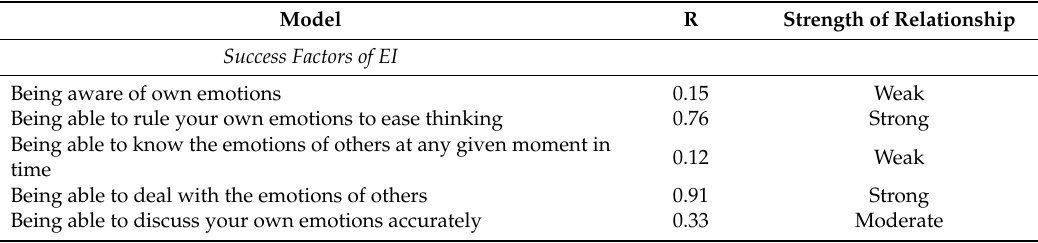
Table 2. Correlation coe ffi cients for the relationship between emotional intelligence and the implication of workers’ emotional intelligence on their commitment to each of the key factors of occupational health and